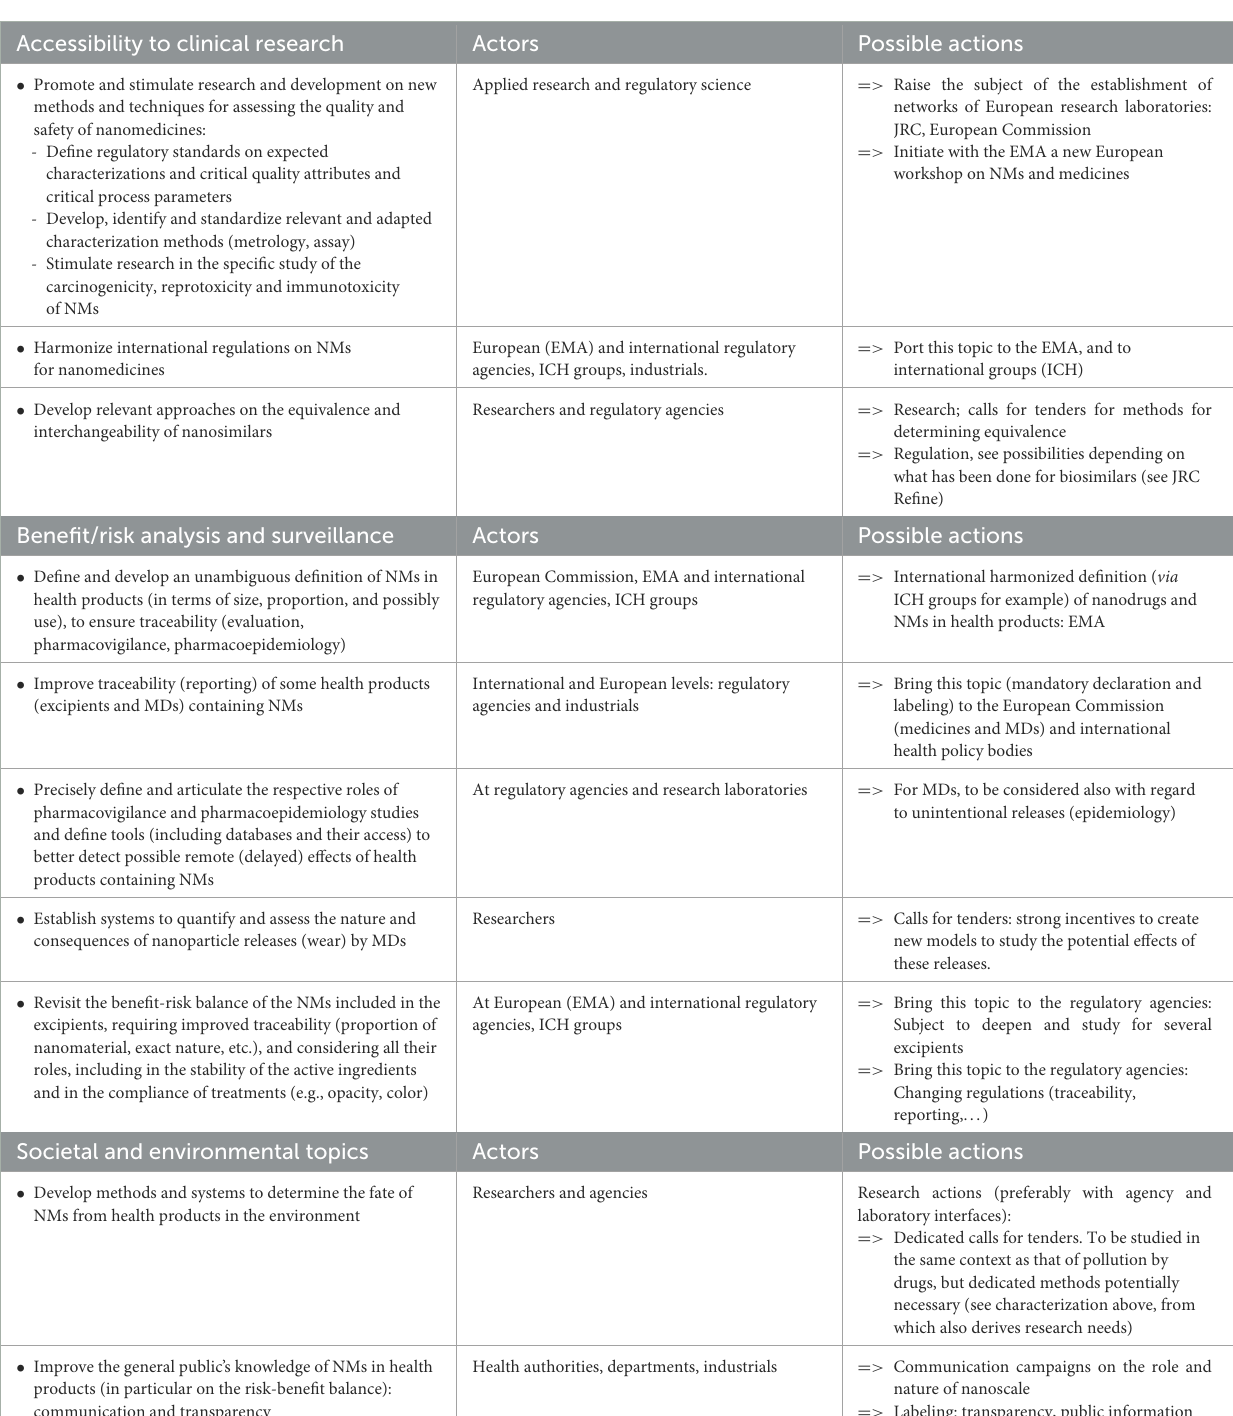
TABLE 1 Actionable recommendations, actors, and possible